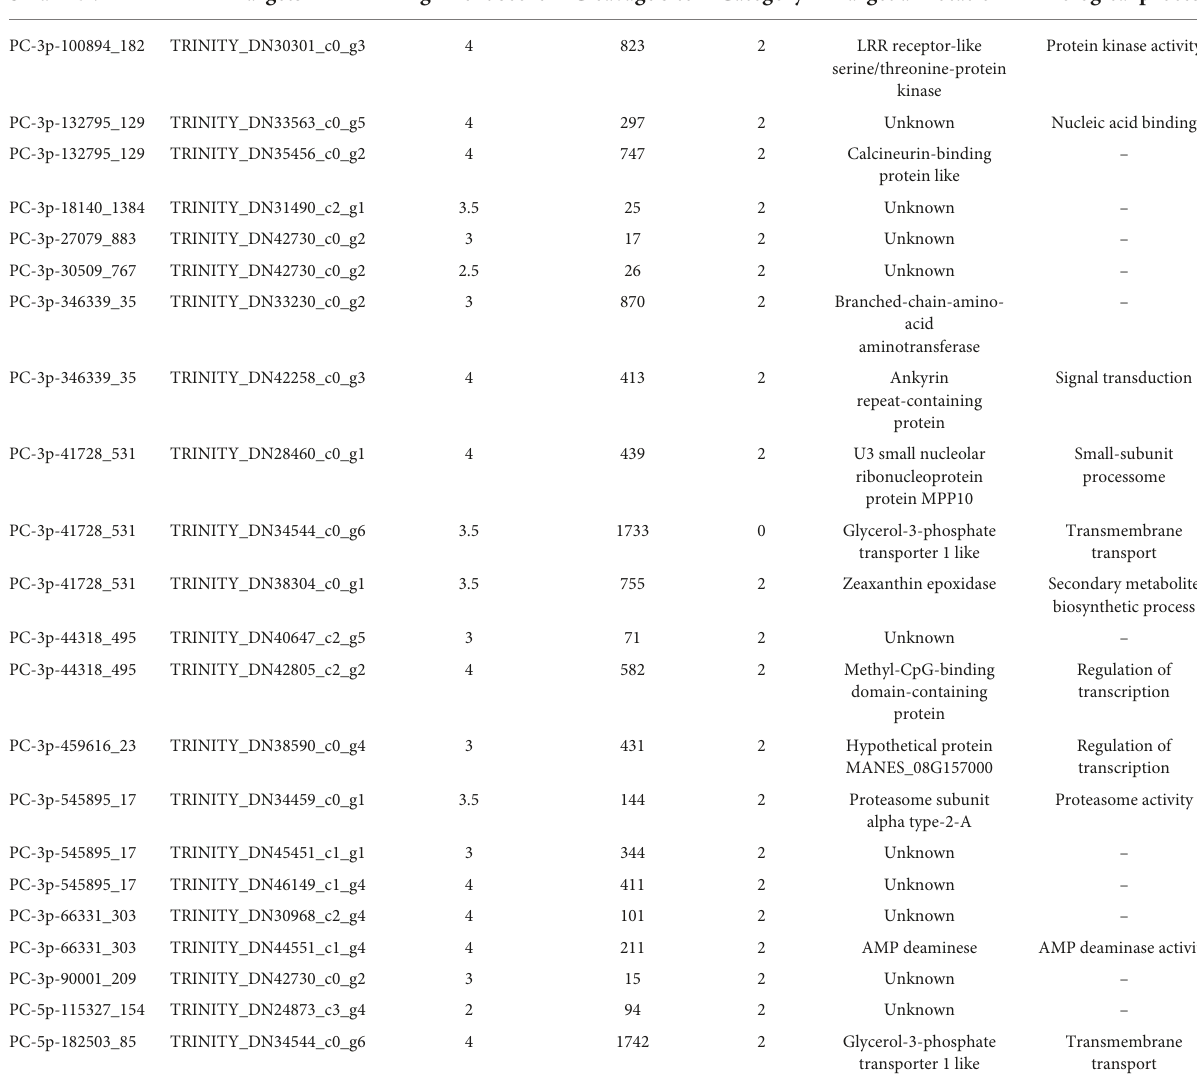
TABLE 2 Target genes of 14 novel miRNAs and their functional annotation. Small RNA